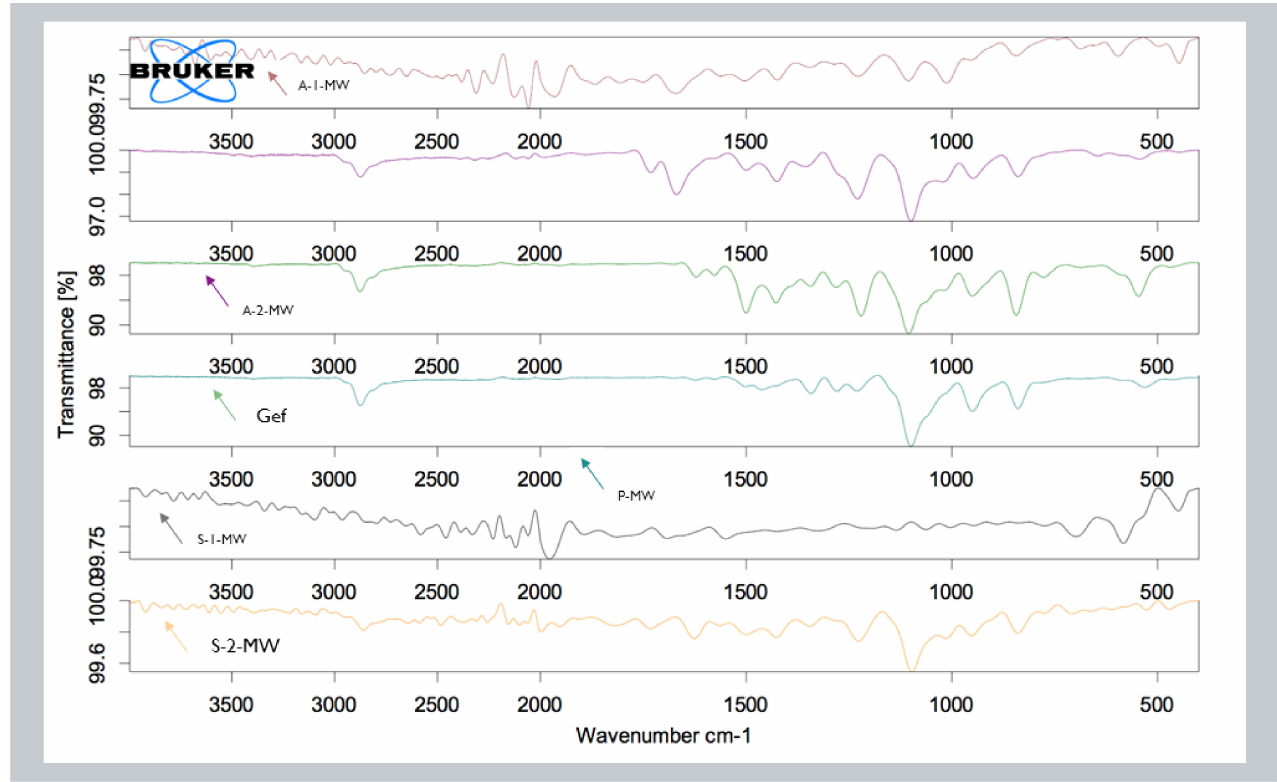
Figure 6. FTIR spectra for pure Gef and different Gef-SDs formulations prepared using microwave